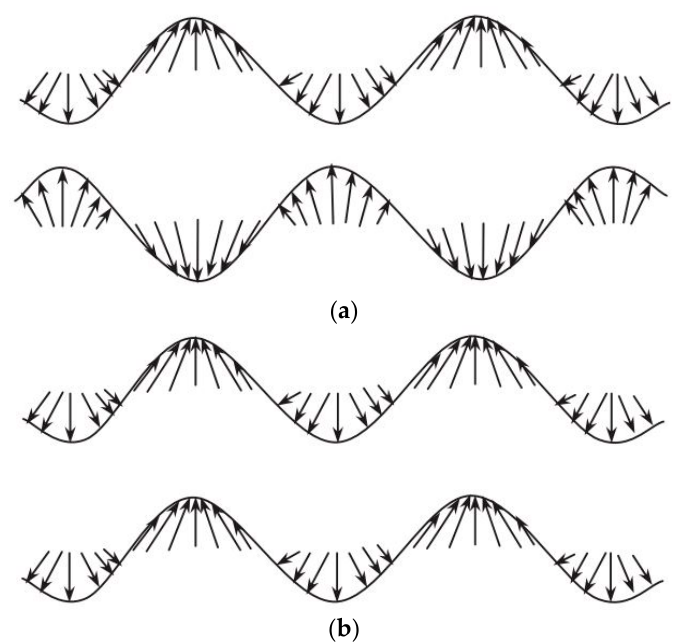
Figure 2. Symmetric ( a ) and anti-symmetric ( b ) Lamb waves [29].